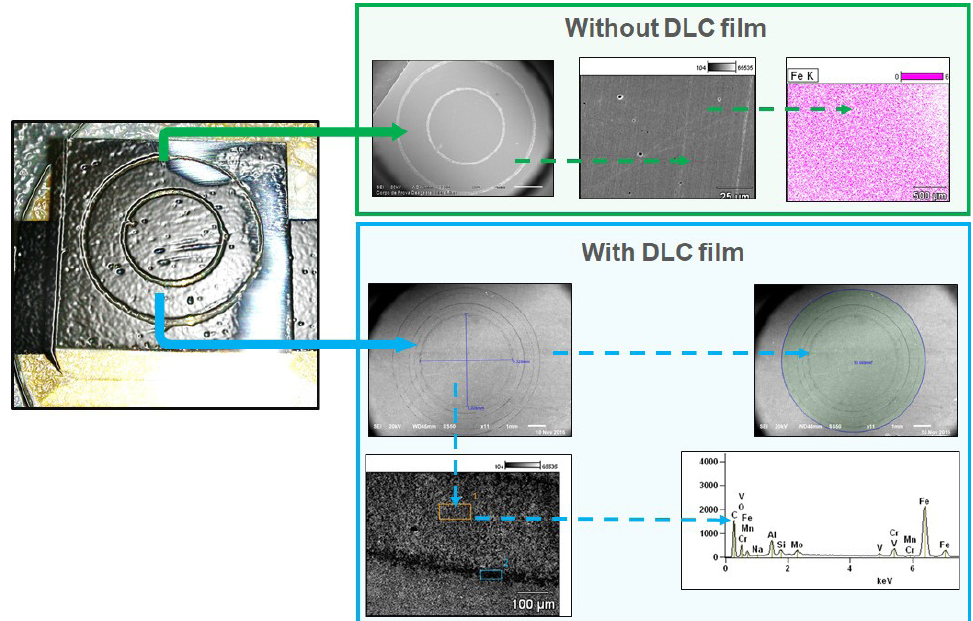
Figure 10. SEM analysis of AISI M35 HSS surfaces with and without DLC